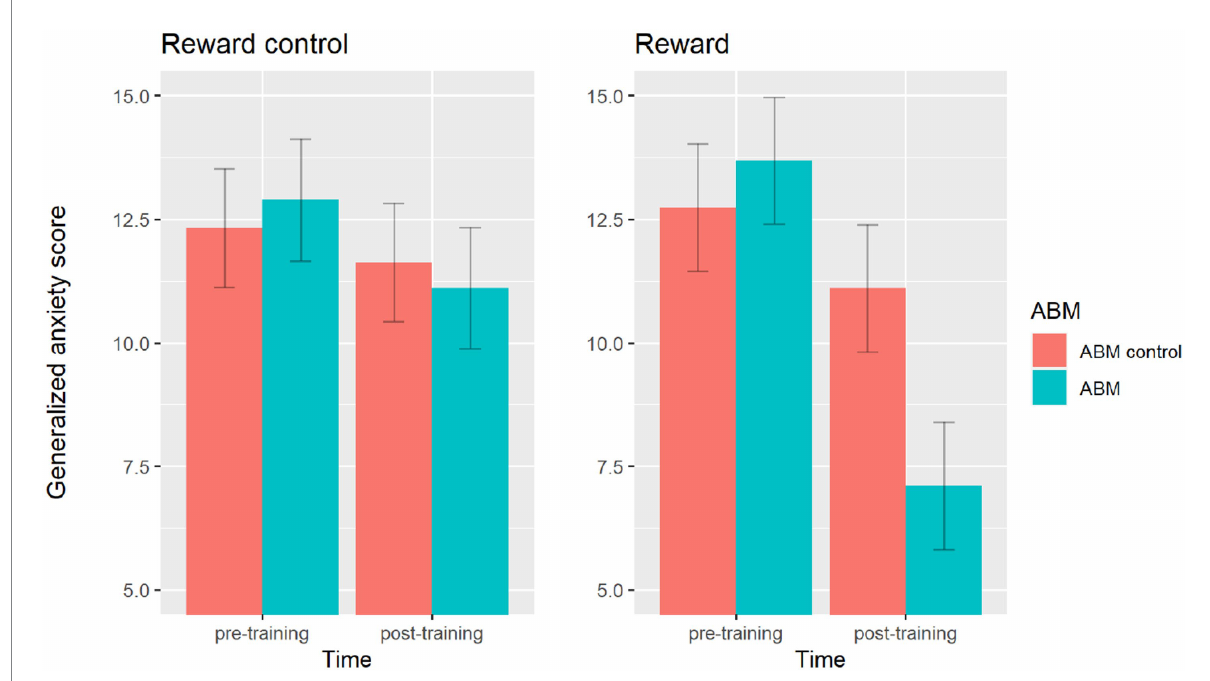
FIGURE 4 Generalized anxiety score for each group before and after training. The Time × Reward × ABM three-way interaction was significant, characterized by a significant Time × ABM interaction in the reward condition but not in the reward control condition. Upper and lower ranges are represented in the figure by the error bars attached to each column.